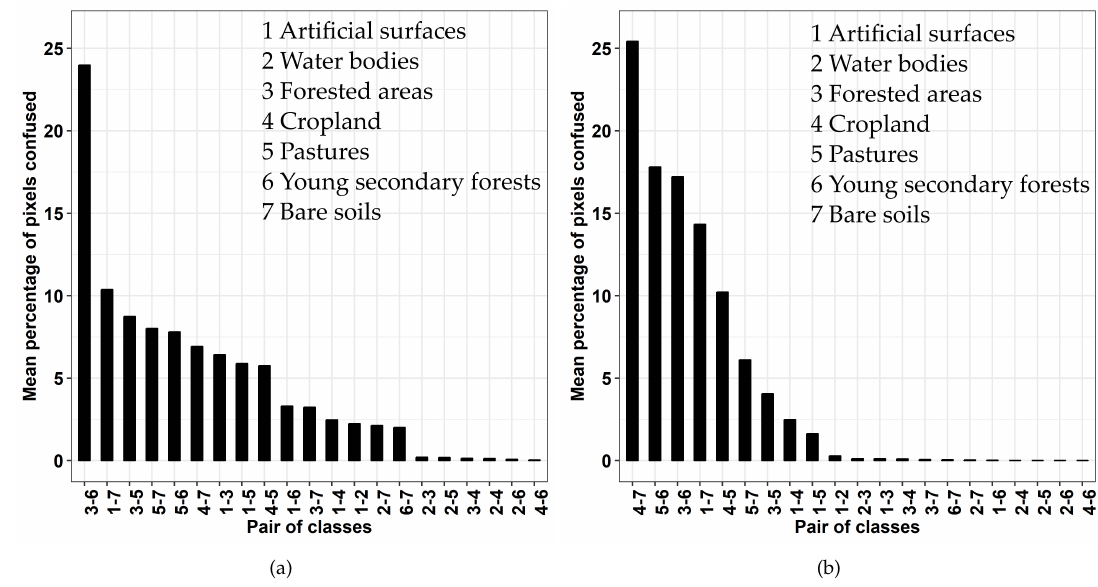
Figure 8. Mean percentage of pixels confused per pair of classes in relation to the total number of misclassified pixels using ( a ) the top ten Sentinel-1 features area and ( b ) the top 7 Sentinel-2 features of the Brazilian study area.